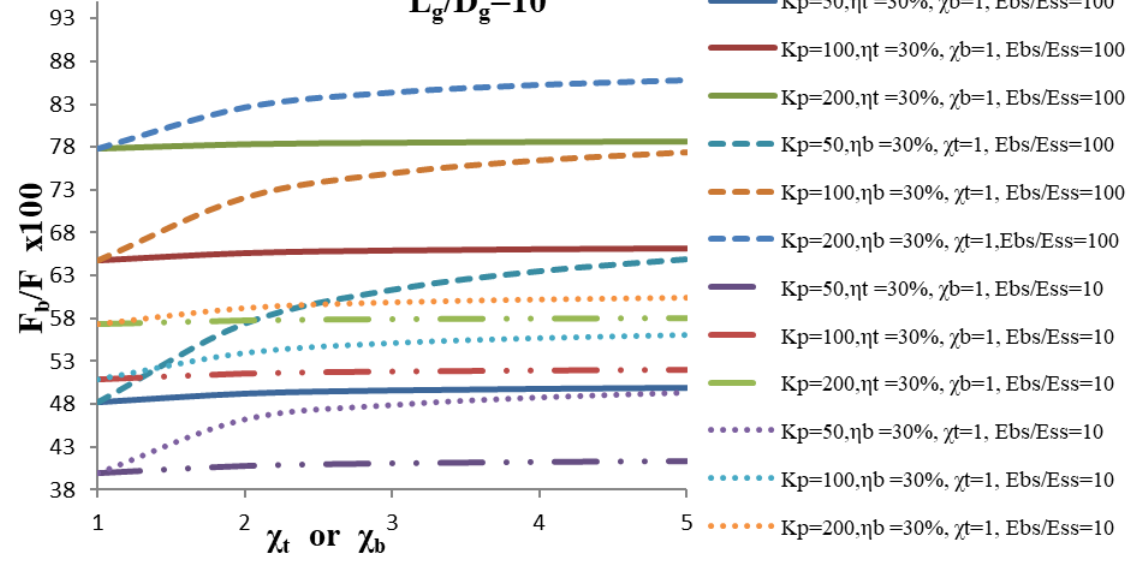
, or strengthening factor for the bottom, χ t /E , on a single partially strengthened GP (L bs ss